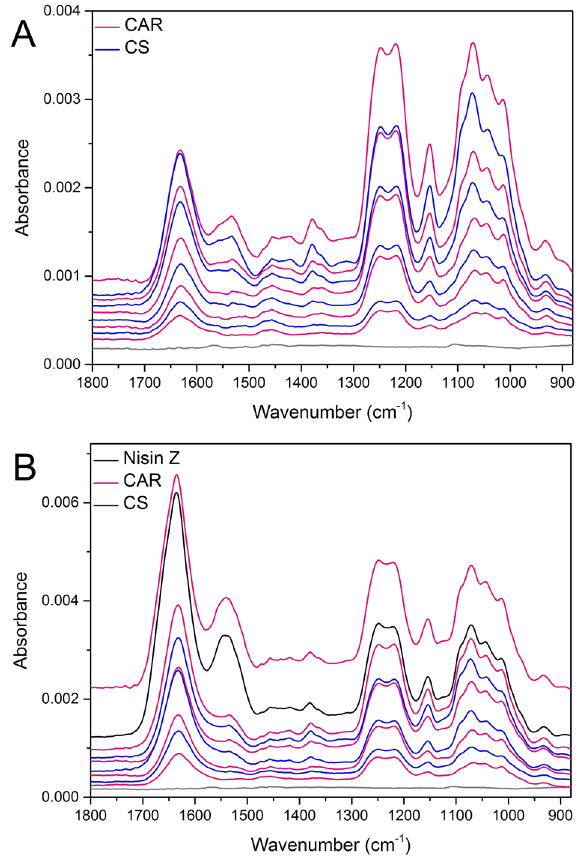
Figure 1. ATR FTIR spectra recorded at each stage of the multilayer build-up for a 4.5 bilayer CAR/CS multilayer (Panel A ) and for a 4.5 bilayer multilayer that contains nisin Z (Panel B ). Formation conditions are noted in the text. Blue lines: spectra recorded after CS adsorption. Pink lines: spectra recorded after CAR adsorption. Black line: spectra recorded after nisin Z